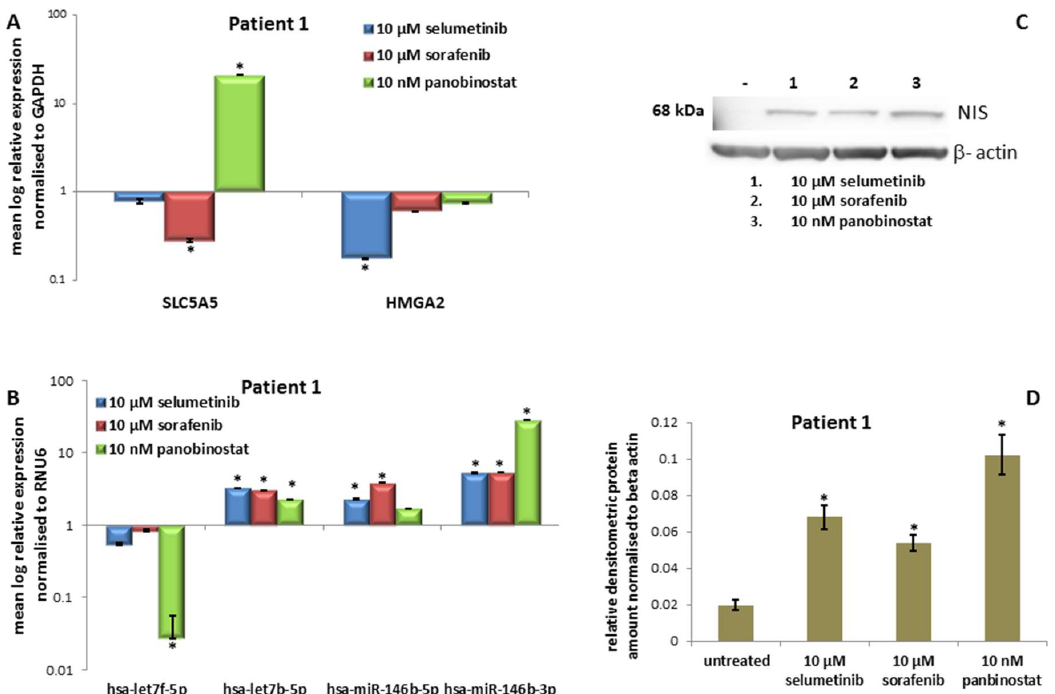
Figure 2. Effects of selumetinib, sorafenib and panobinostat on mRNAs, miRNAs and NIS protein expression in PDTT of patient 1 (ATC). RT-qPCR of NIS , HMGA2 ( A ), hsa-let7f-5p, hsa-let7b-5p, hsa-miR-146b-5p and hsa-miR-146b-3p ( B ). The expression was normalised to